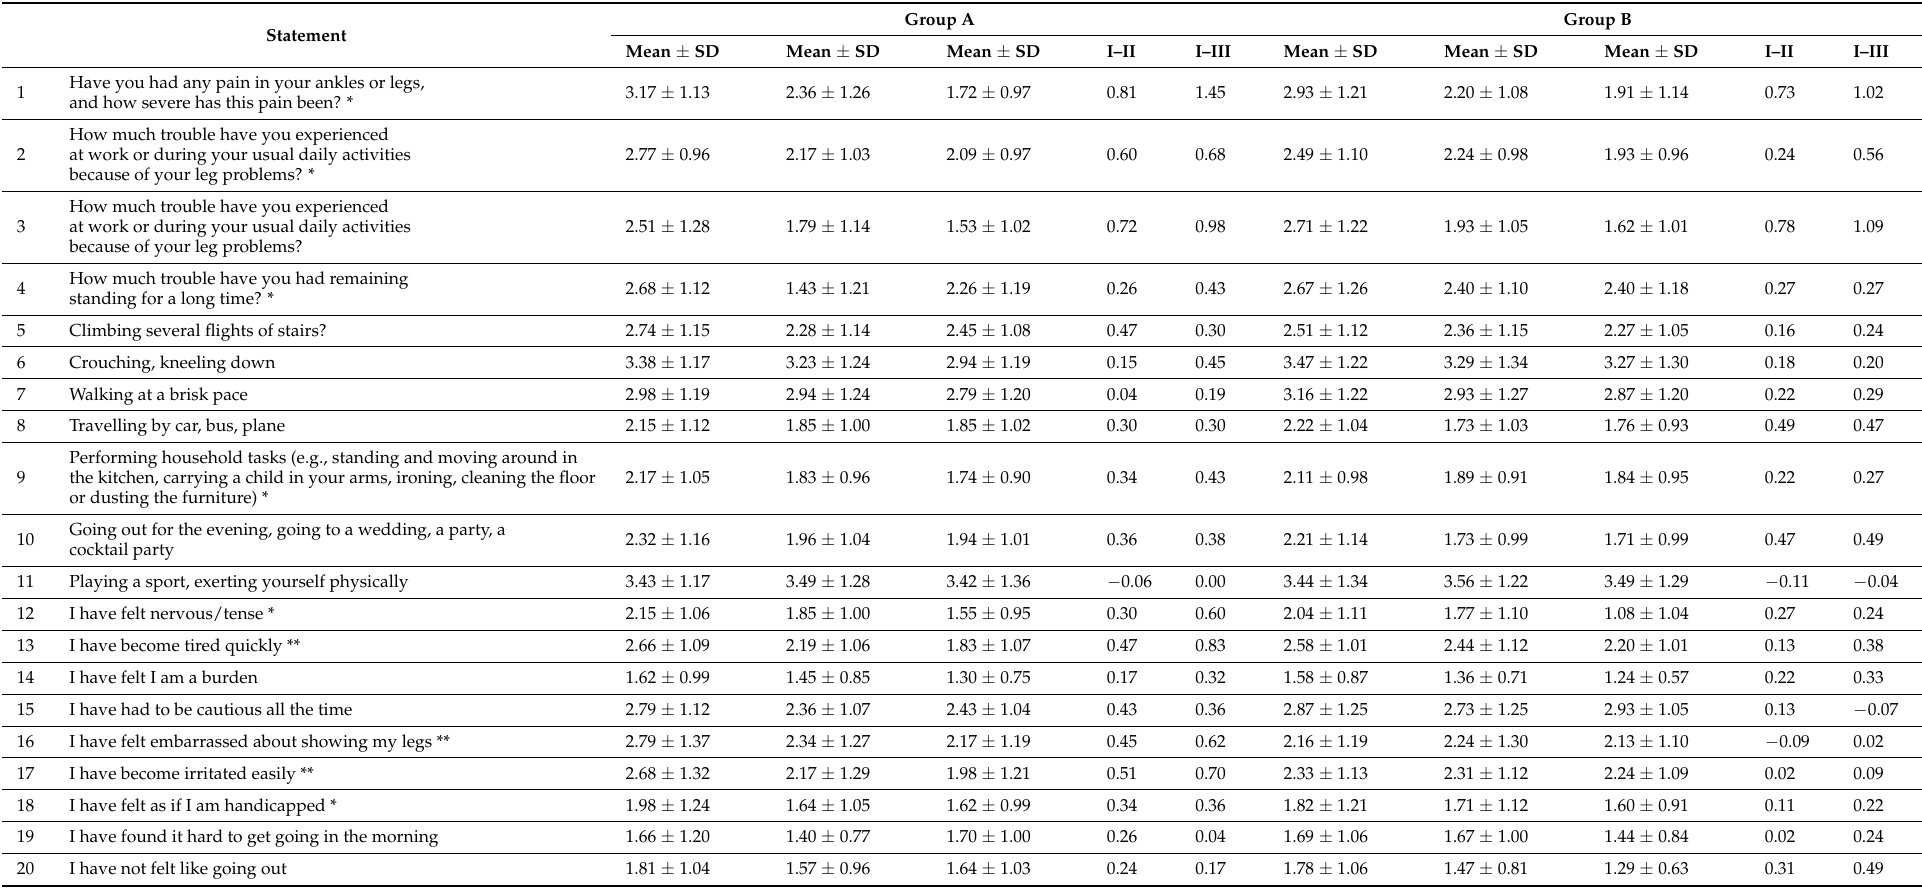
Table 4. Comparison of changes in the quality of life in individual statements of the CIVIQ scale in the studied